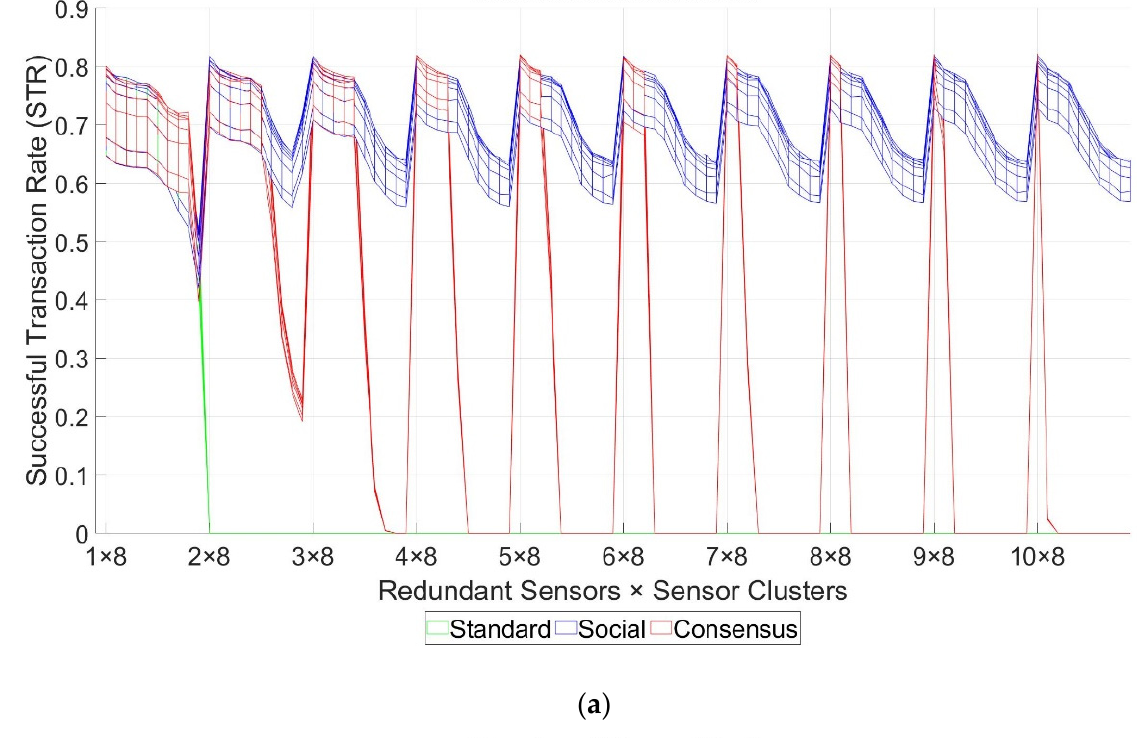
Figure 5. Trustworthiness mesh graph for the standard operational mode (green), the redundancy mode with Social Trust- worthiness (blue), and the redundancy mode with Consensus mechanism (red).